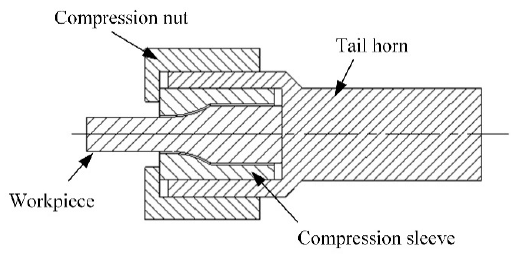
Figure 3. Tensile specimen of the SiCp/Al composite.